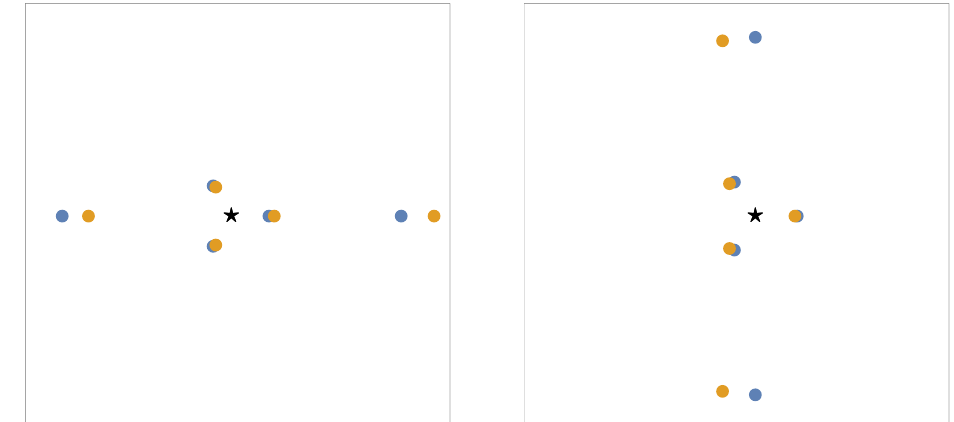
Figure 1 . On the left, the case of the degenerate partition (4 , 1) , and on the right the conjugate case (2 , 1 , 1 , 1) . In yellow the numerical solution with L = 7 × 10 4 and α = π solution according to formula (10.2). The star is the point z = L